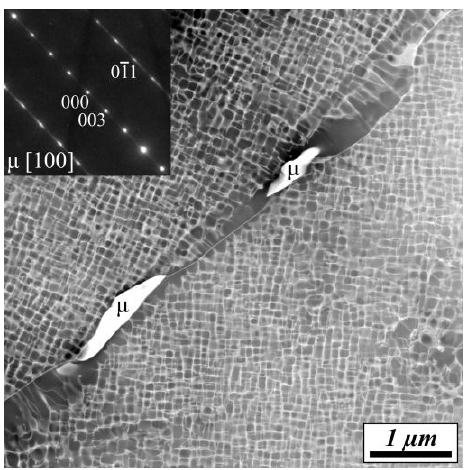
Figure 7. STEM-HAADF micrograph from SEBM Specimen B showing a dark grain boundary γ′ phase and μ phase particles. The SAD pattern in the upper left, which can be indexed for µ phase, was taken from the particle in the lower left (for details see text).